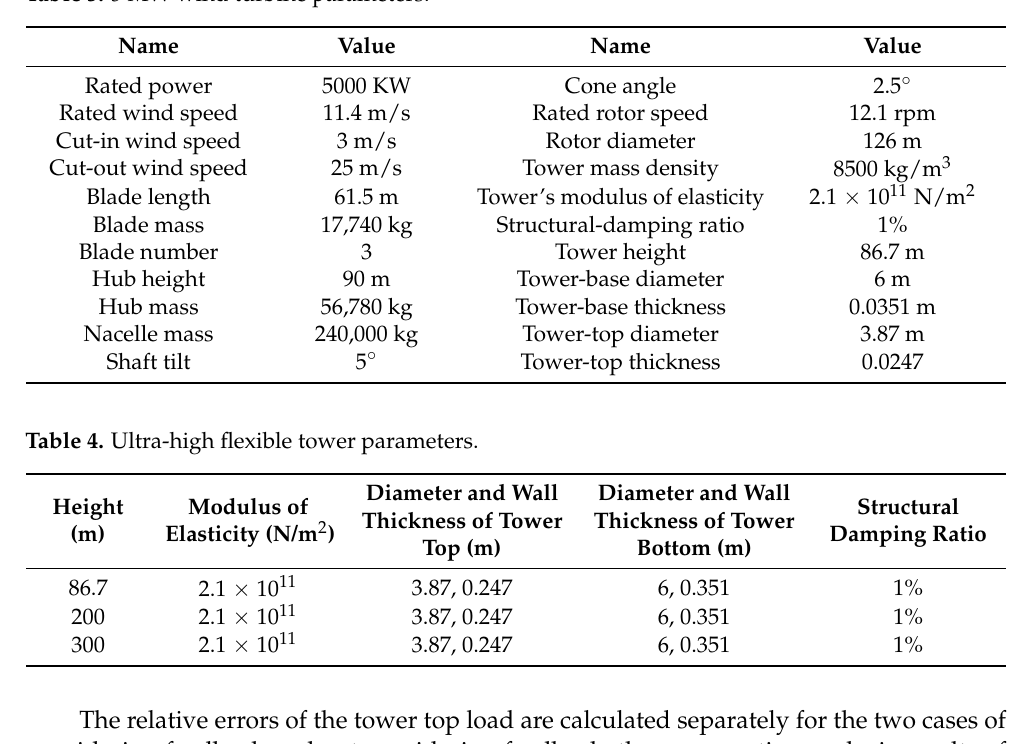
Table 3. 5 MW wind turbine parameters.